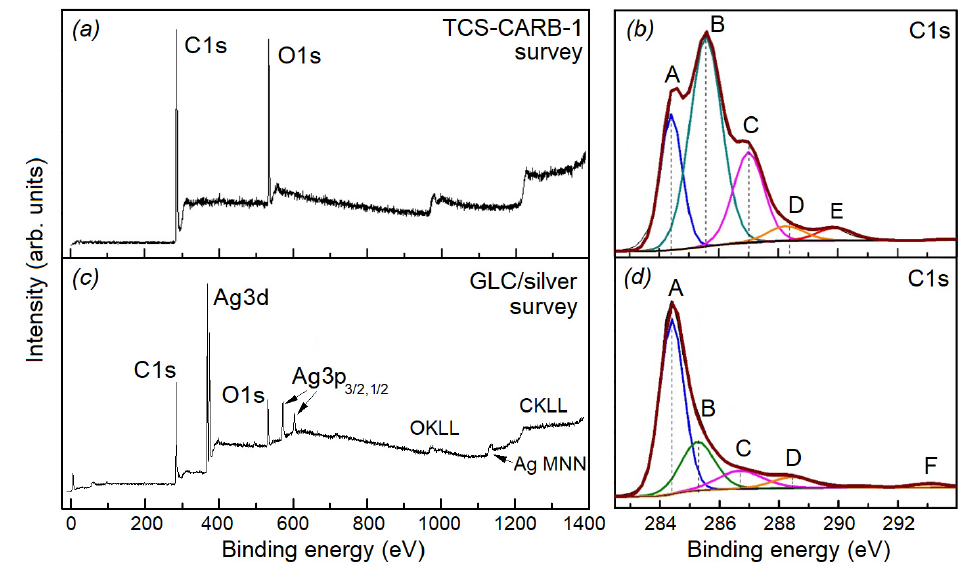
Figure 3. XPS spectra of the target material and carbon film, deposited on silver. Survey ( a , c ) and high-resolution C1s spectra ( b , d ). Table 1. The percentage of carbon bonds in the target material and in the carbon film deposited on silver.